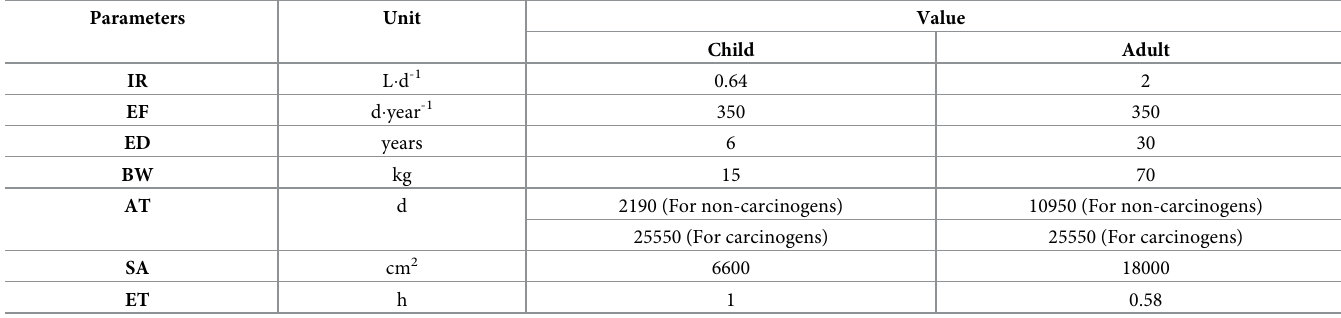
Table 2. Exposure parameters for the health risk assessment